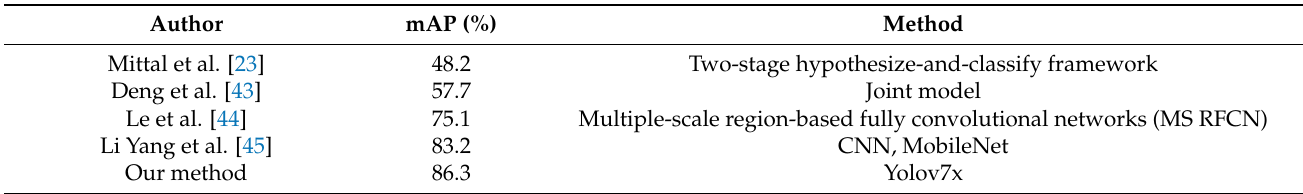
Table 4. Previous research comparison on the Oxford Hand